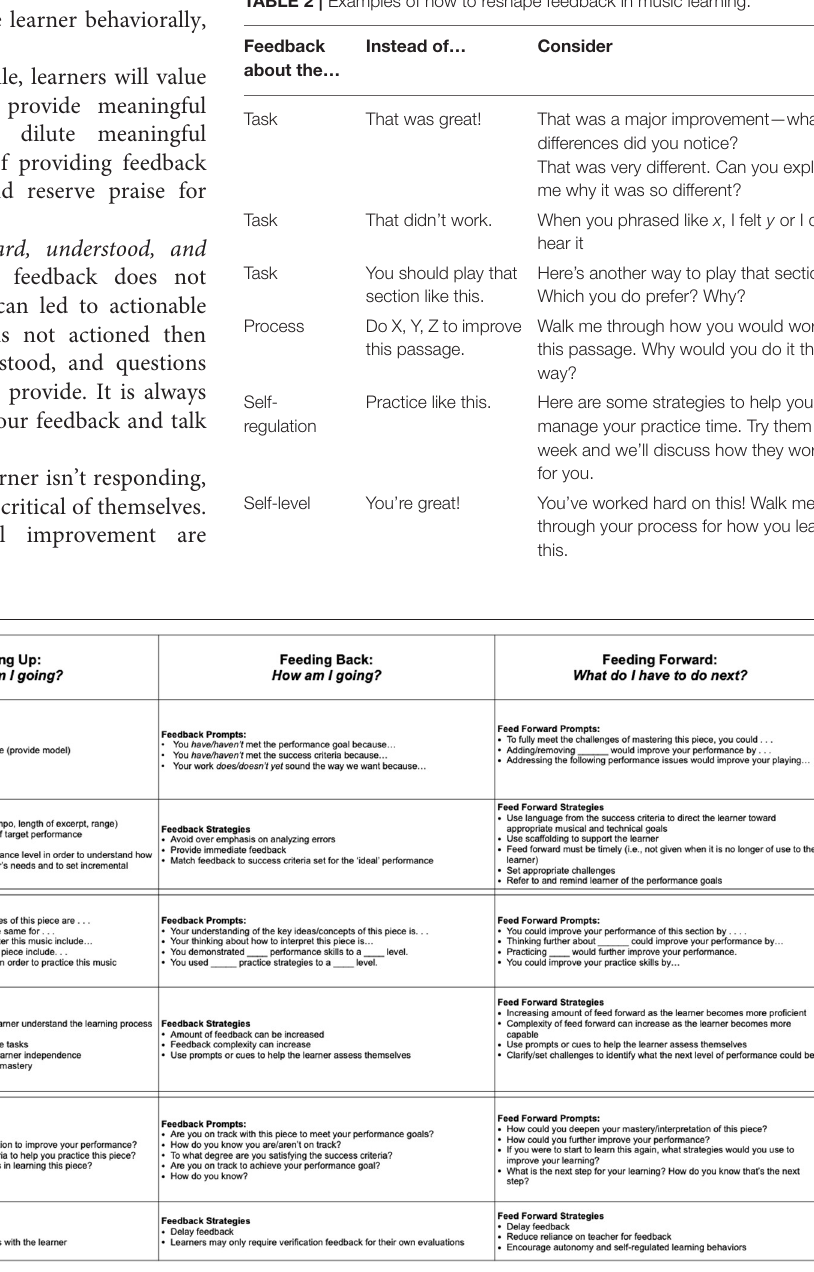
Frontiers in Psychology |